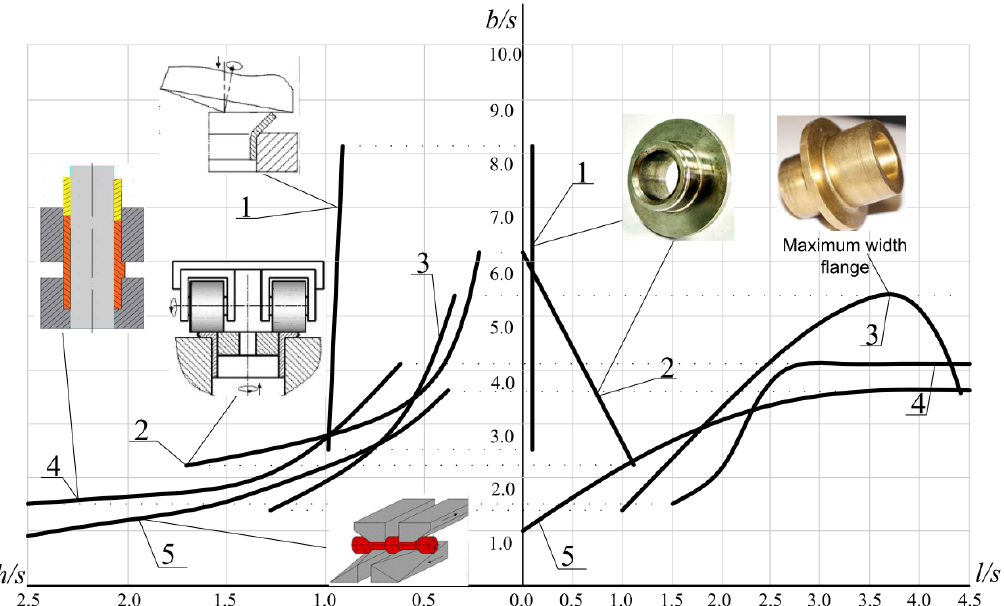
Figure 3. Technological capabilities of the process of the cold metal forming of parts with flanges: 1—a curve limiting the area of the axial rotary forging the flanging scheme; 2—a curve limiting the area of rolling according to the scheme of rotary forging; 3—a curve limiting the area of rolling according to the scheme of angular rolling; 4—a curve limiting the area of manufacturing flange parts according to the radial extrusion scheme; and 5—a curve limiting the area of flange parts production according to the cross wedge rolling scheme.